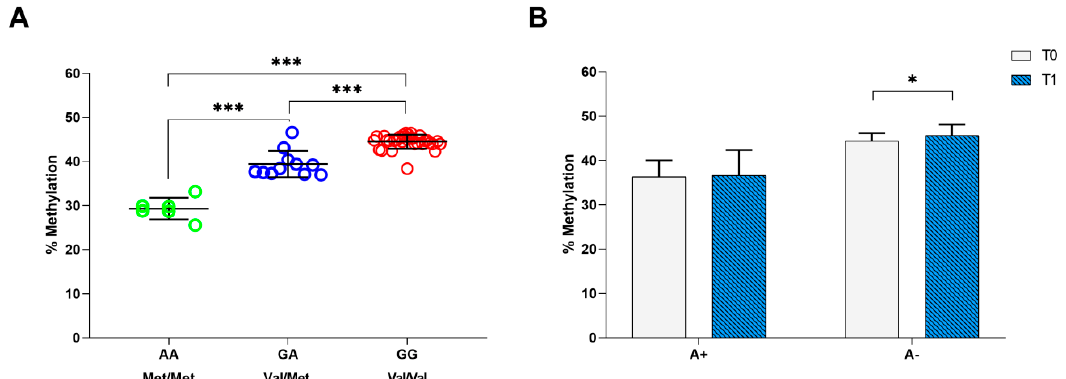
Figure 2. Methylation analysis of BDNF rs6265 polymorphism. ( A ) Average percentage of methylation in patients with stroke carrying the GG (Val/Val), GA (Val/Met) and AA (Met/Met) alleles. ( B ) Average percentage of methylation before and after the 30-session rehabilitation intervention for patients carrying A+ and A − alleles. The asterisks indicate a statistically significant difference: *** p < 0.001 and * p < 0.05, according to the paired t -tests.